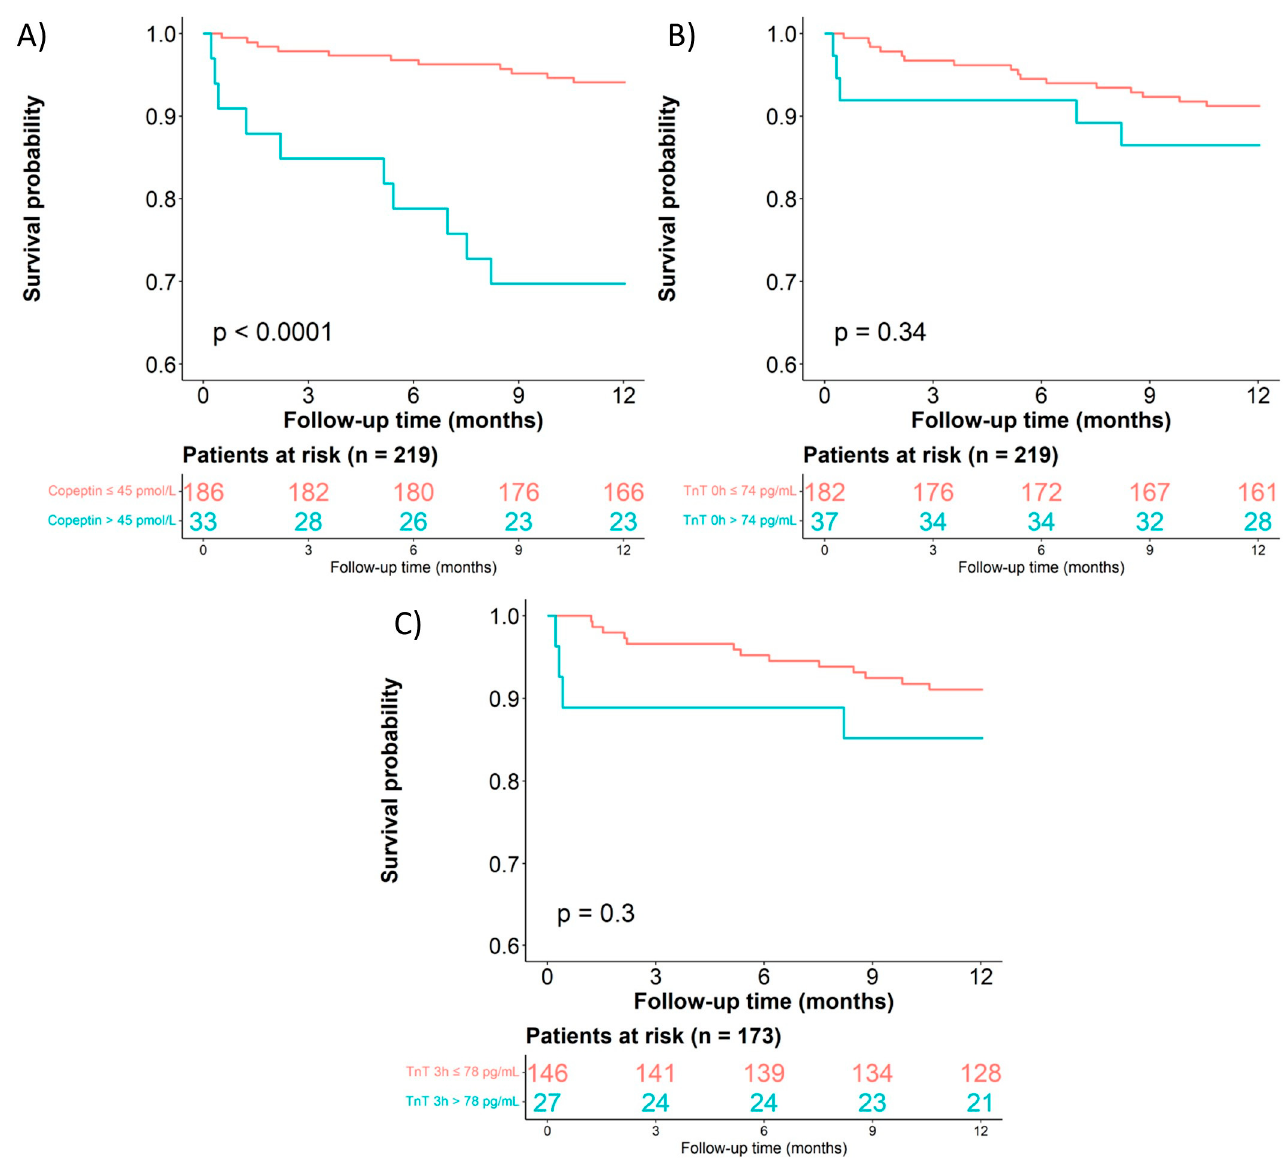
Figure 3. Kaplan–Meier curves. ( A ) Copeptin ≤ 45 vs. >45 pmol/L by all-cause death at 365 days. ( B ) hs-cTnT at 0 h ≤ 74 vs. >74 ng/L by all-cause death at 365 days. ( C ) hs-cTnT at 3 h ≤ 78 vs. >78 ng/L by all-cause death at 365 days. Table 4. Cox regression models for prediction of all-cause death at 365 days.